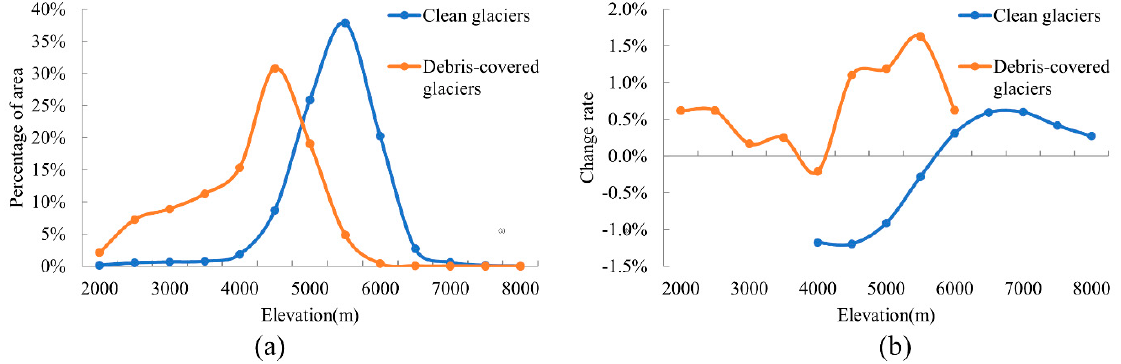
Figure 8. Changes in glacier area at different elevations on the Tibetan Plateau. ( a ) Percentage of area and ( b ) average annual rate of change at different elevations.